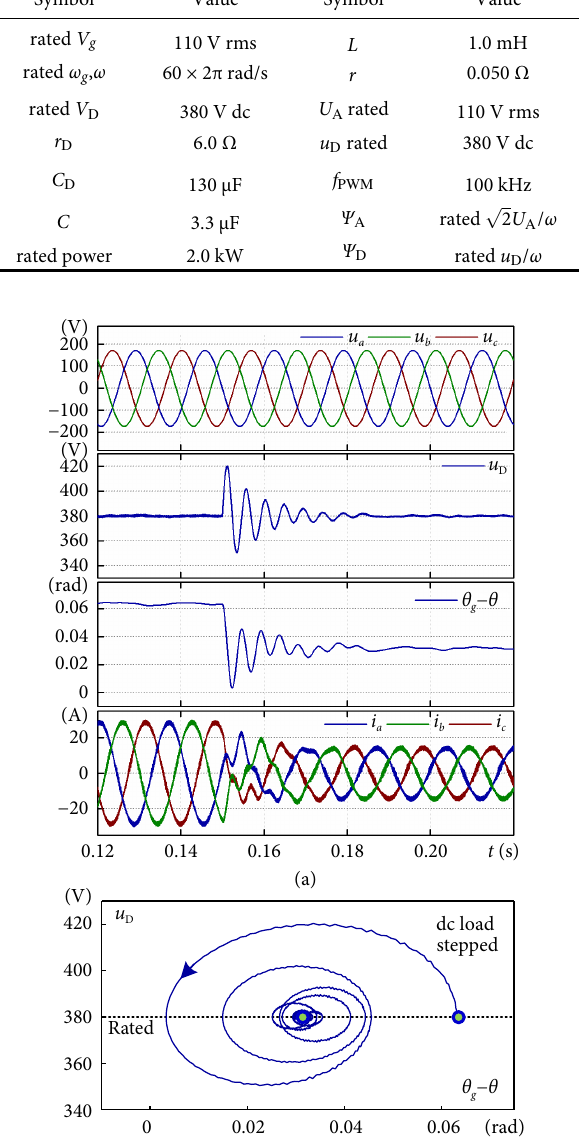
duct an experimental verification. The configuration of the microgrid is the same as shown in Figure 5. The system parameters are the same as in Table 2.